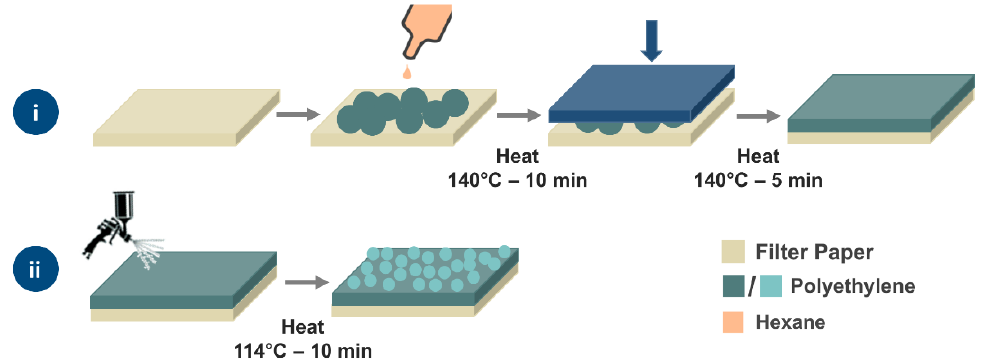
Figure 2. A schematic showing the fabrication method of the PE micropowder filters. For the primary layer ( i ), the PE micropowders are placed on a filter paper, dispersed by hexane and heat-treated (140 °C), followed by compacting and further heating. The second layer ( ii ) of PE is deposited by spray coating a suspension of particles in hexane and is annealed at 114 °C.